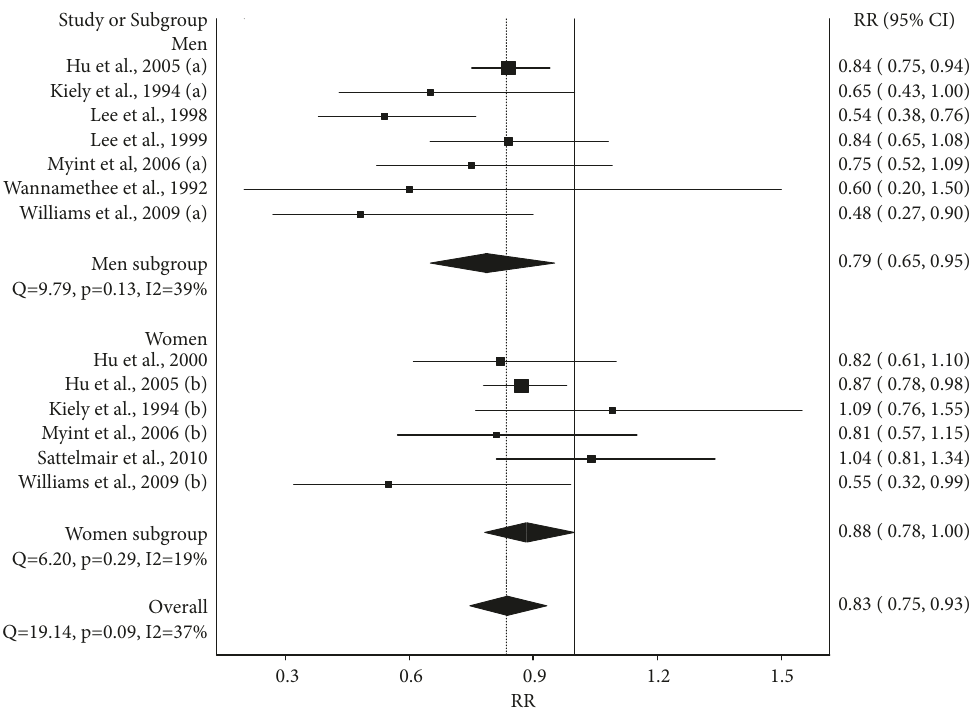
Figure 1: Forest plot for the association between moderate versus low leisure time physical activity and the relative risk of fatal or nonfatal stroke (hemorrhagic or ischemic) using the IVhet model. The black squares represent the relative risks (RR) while the left and right extremes of the squares represent the corresponding 95% confidence intervals for the RR. The middle of the black diamonds represents the RR while the right and left extremes of the diamond represent the corresponding 95% confidence